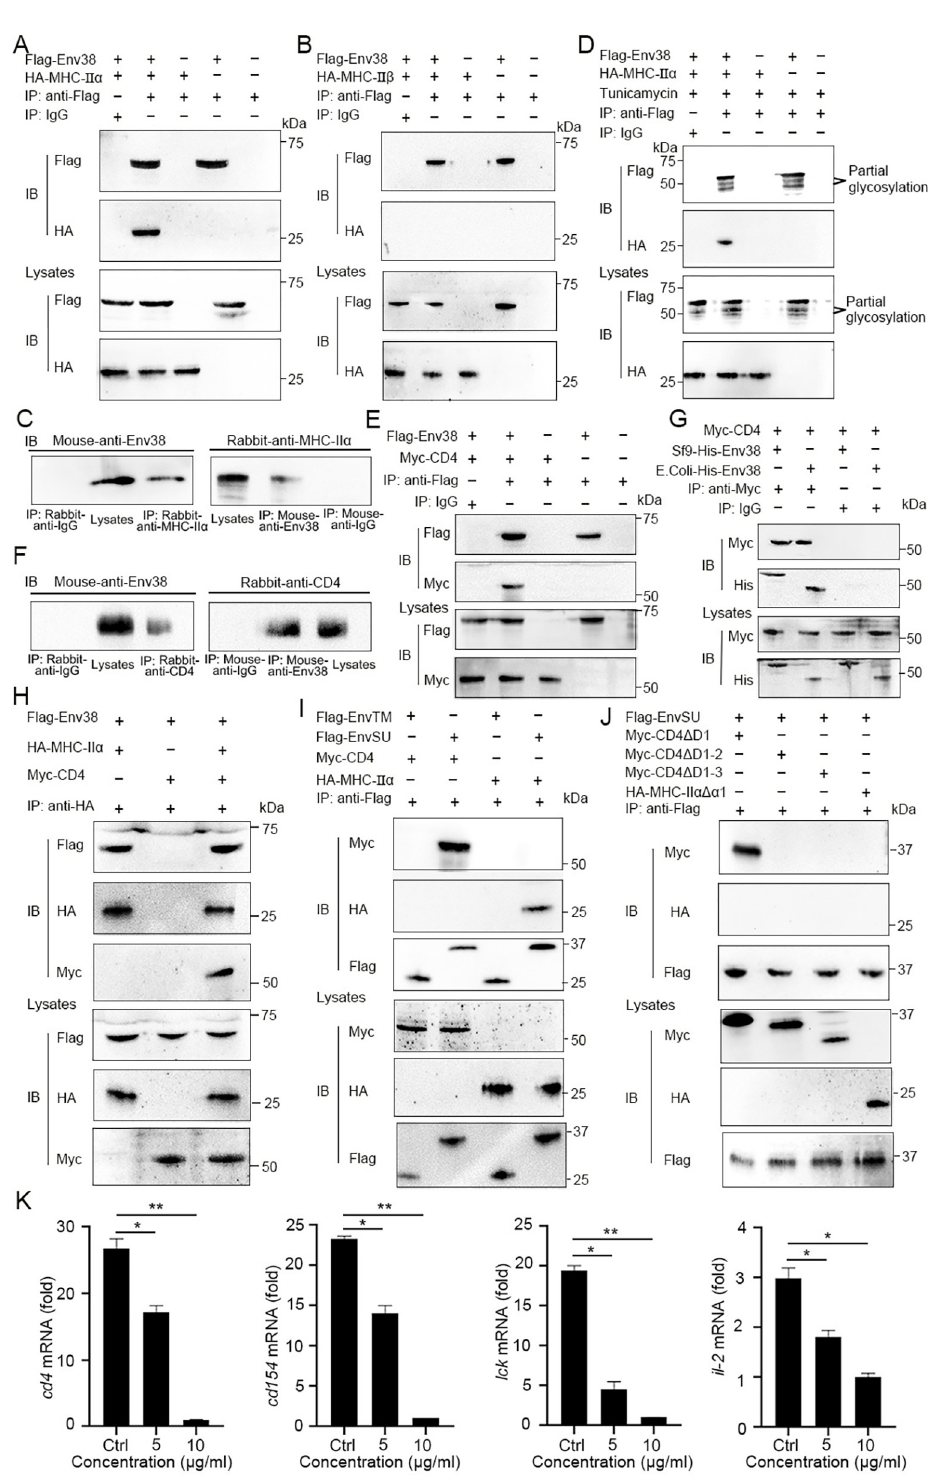
Fig 10. Examination on the association of Env38 with MHC-II and CD4 proteins and their domain interactions. (A and B) Examination on the interaction between Env38 and MHC-II α or MHC-II β , in which the Flag-tagged Env38 and HA-tagged MHC-II α (A) or HA-tagged MHC-II β (B) were coexpressed in HEK293T cells, followed by immunoprecipitation with rabbit anti-Flag or rabbit IgG (negative control). Western blot was performed with mouse anti-Flag or anti-HA Ab. (C) Examination on the interaction between leukocyte Env38 and MHC-II α proteins of